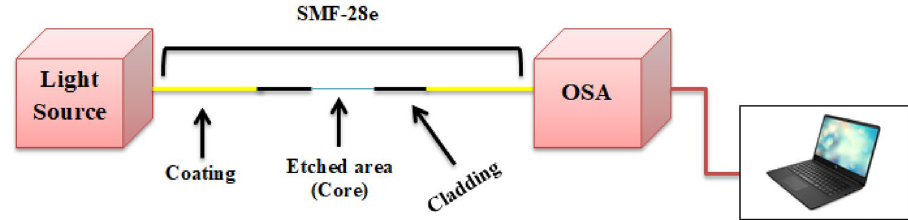
Figure 2. Shows the experimental